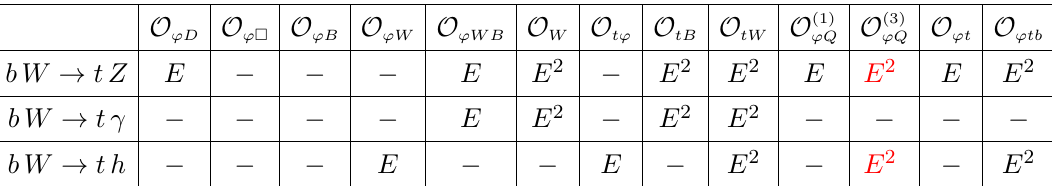
Table 5. Maximal energy growths induced by each operator on the set of single top scattering amplitudes considered. ‘ ’ denotes either no contribution or no energy growth and the red entries (cid:0) denote the fact that the interference between the SMEFT and the SM amplitudes also grows with